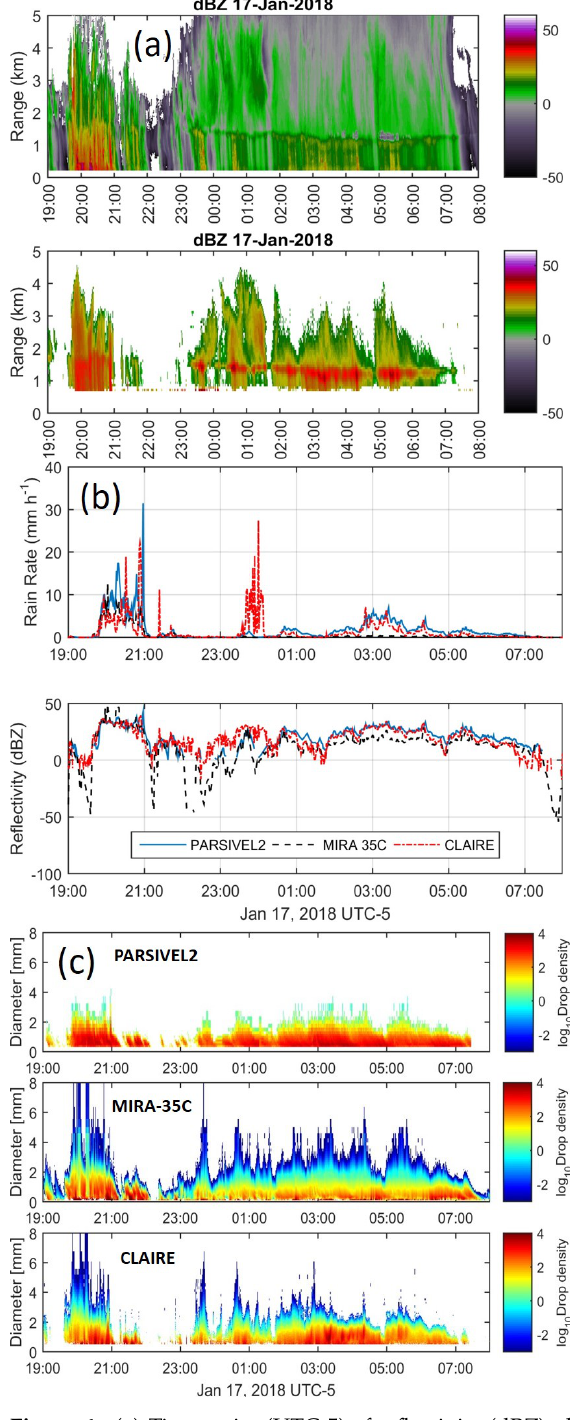
Figure 4. ( a ) Time series (UTC-5) of reflectivity (dBZ) obtained from the Magnetron-based cloud radar (MIRA-35C) (top figure) and CLAIRE (bottom figure) above the HYO for the event on 17 January 2018. ( b ) Time series of rain rate (mm h − 1 ) (top figure) and reflectivity (dBZ) (bottom figure) obtained from PARSIVEL2 at a 2 m height, MIRA-35C at a 250 m height and CLAIRE at a 750 m height. ( c ) Time series of raindrop size distribution (mm) with a density of the particles obtained from the PARSIVEL2 (top figure), MIRA-35C (middle figure), and CLAIRE (bottom